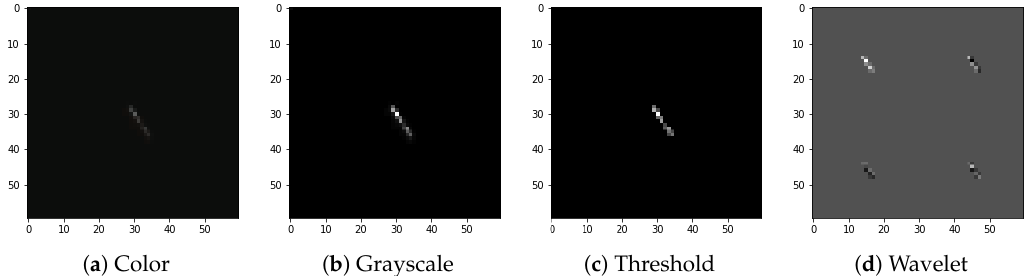
Figure 5. Preprocessing flow: ( a ) color input image, ( b ) grayscale accumulation, ( c ) adaptive thresholding, ( d ) wavelet transformation. Example of the track-type image.